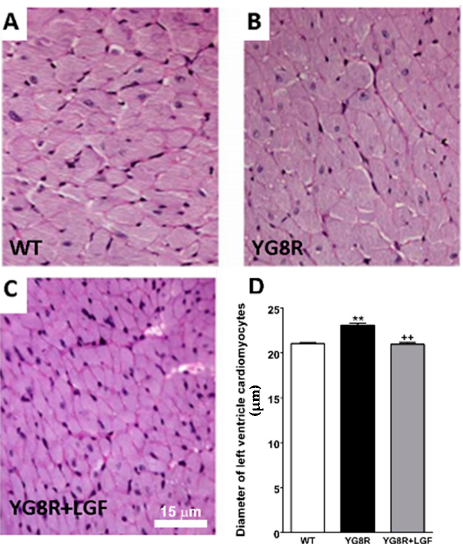
Figure 4. LGF treatment ameliorates cardiac hypertrophy in YG8R mice. ( A ) to ( C ) show hematoxylin ( blue ) and eosin staining ( pink ) of left ventricle coronal sections of WT, YG8R, and YG8R+LGF mice, Scale bar = 15 μ m; ( D ) Represents the quantification of the diameter of cardiomyocytes in the three experimental groups. Note the increase of this parameter in YG8R mice ( black bar), which is prevented with LGF treatment ( gray bar). Results in ( D ) are the mean ± SEM of 360–420 cardiomyocytes from six independent mice in each experimental group. ** p < 0.01 vs. WT; ++ p < 0.01 vs. YG8R.